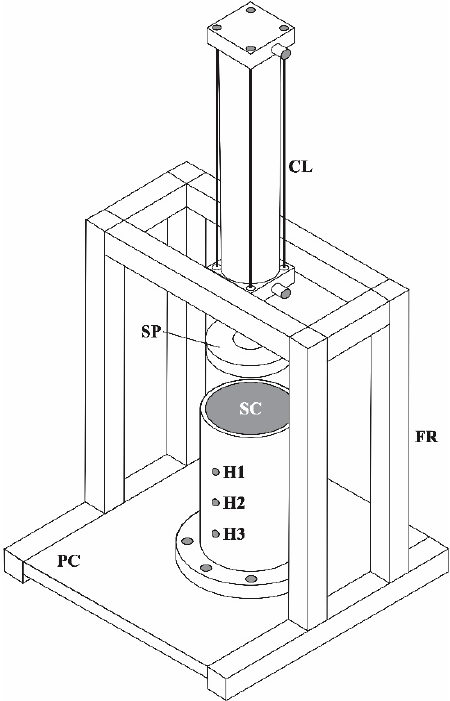
Figure 2. Designed compost compact device used in this study. Legend: PC—base and platen cover; SC—PVC sample cylinder; FR—steel frame; CL—cylinder; SP—steel piston; and H1, H2, and H3—holes over cylinder used to measure the thermal properties.